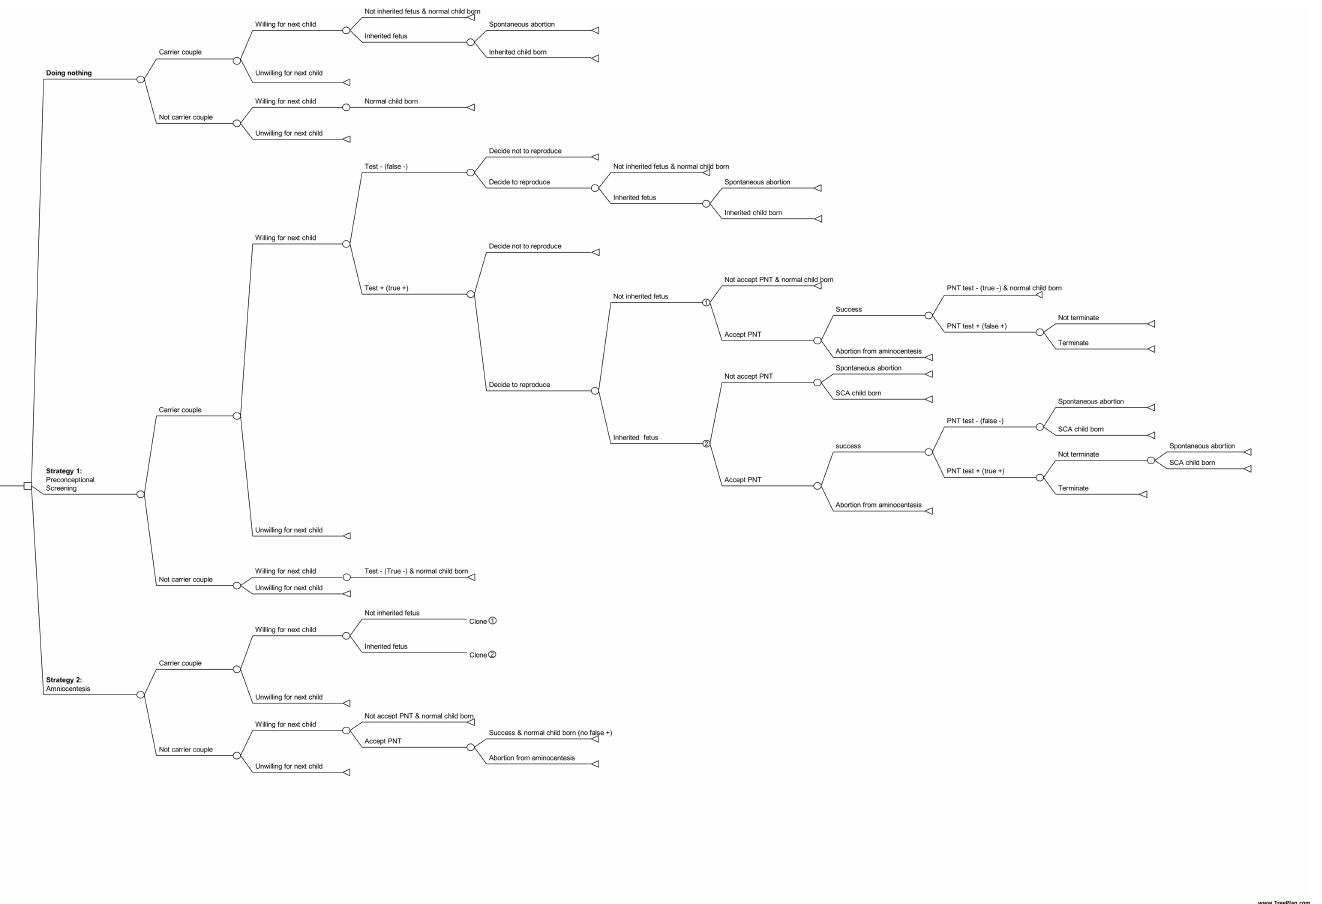
Fig 1. Decision tree of diagnostic strategies for the reduction of recurrent structural chromosome abnormalities in